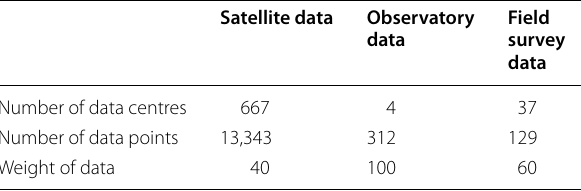
Their respective numbers of data centres, and the chosen weight for each data set are presented in the